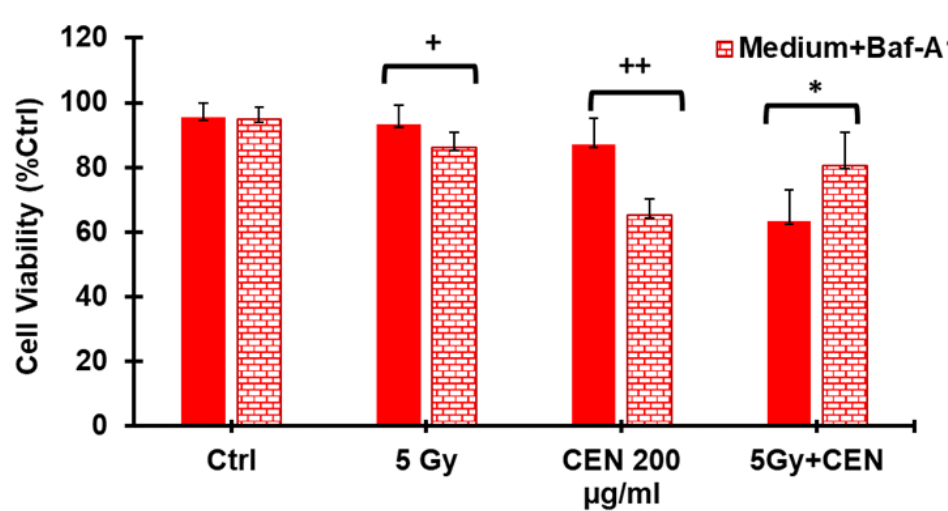
Figure 7. IR and CEN induce protective autophagy in the SAOS400 cell line, but their combination results in lethal autophagy (ADCD). SAOS400 cells were treated with γ -rays (5 Gy), CEN (200 µ g/mL), or their combination for 72 h in the absence or presence of the autophagy inhibitor Baf-A1 (10 nM). At the end of incubation, a Crystal Violet assay was performed to calculate cell viability under the different experimental conditions. The bar graphs represent the mean ± SD, and symbols and the linear bar indicate significance: + p < 0.05 vs. IR + Baf-A1, ++ p < 0.01 CEN vs. Baf-A1, * p < 0.05 IR + CEN vs. IR+CEN+Baf-A1, Student’s t